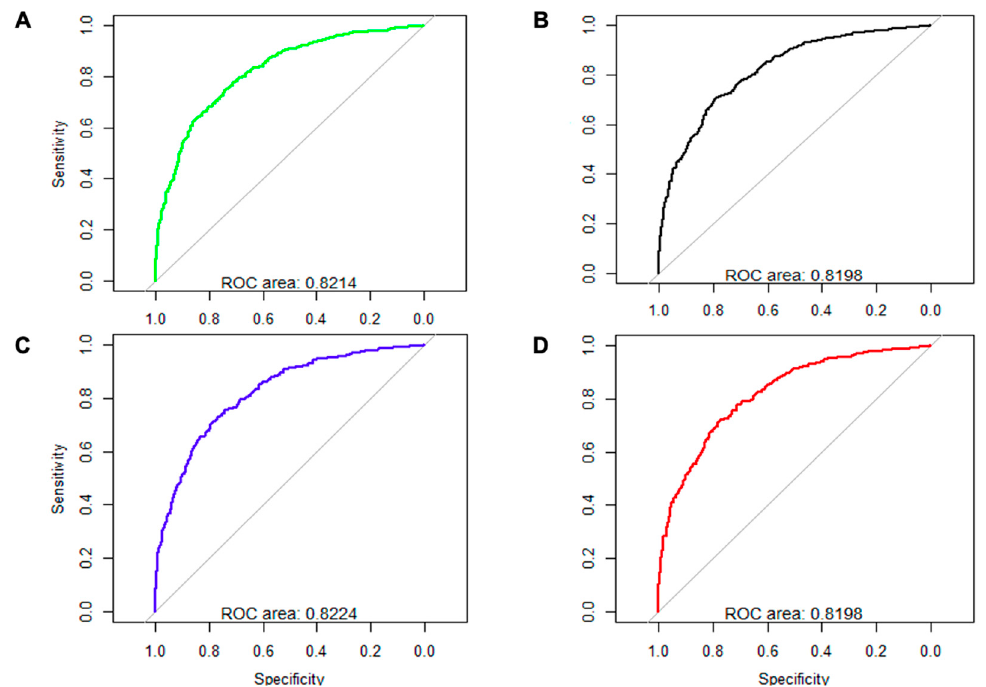
Figure 1. Multivariate analysis and ROC curves for baseline serum albumin alone (g/dL) ( A ), C-reactive protein (CRP) alone (mg/L) ( B ), their additive combination ( C ), and CRP/bSA ratio ( D ).